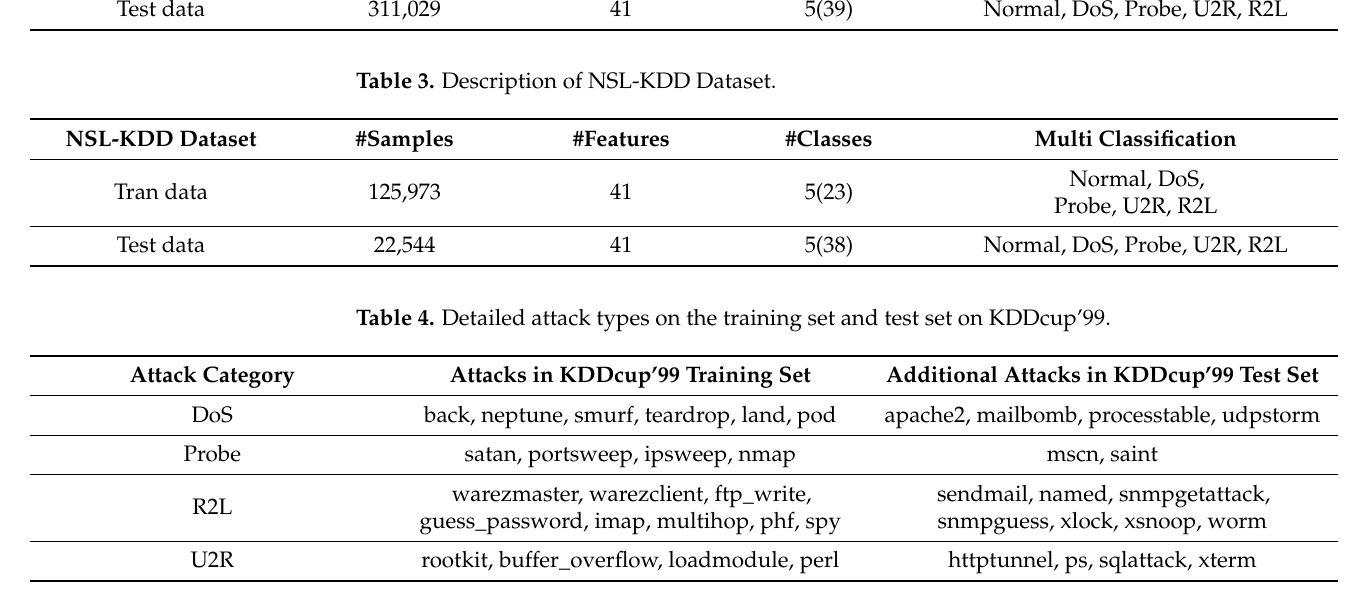
Table 5. Attacks in Testing Dataset of NSL-KDD.